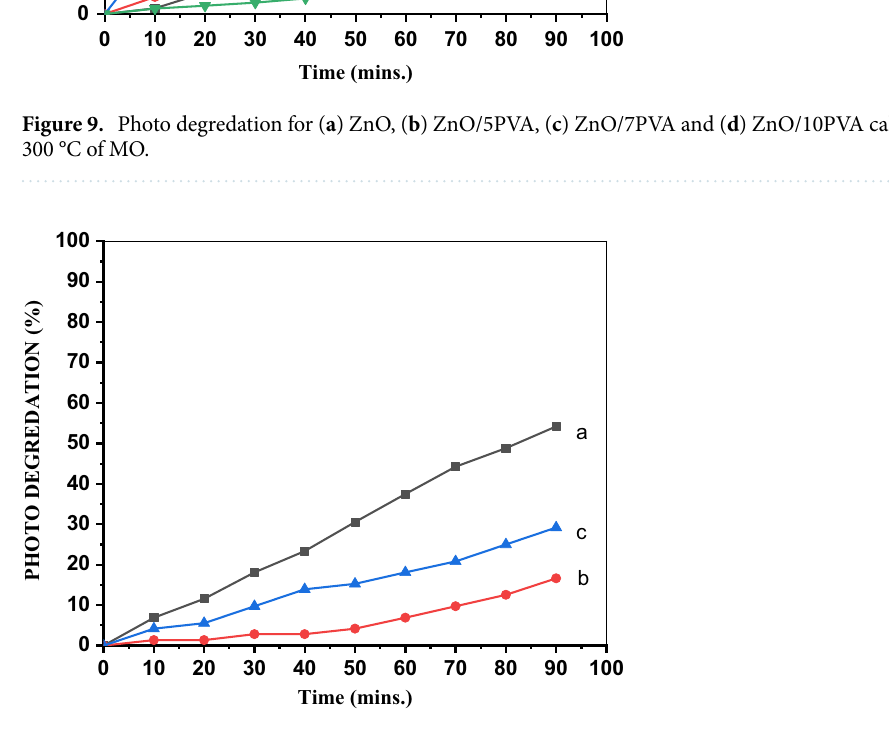
Figure 10. Photo degredation of MO by ZnO/7PVA calcined at ( a ) 300, ( b ) 400 and ( c ) 500